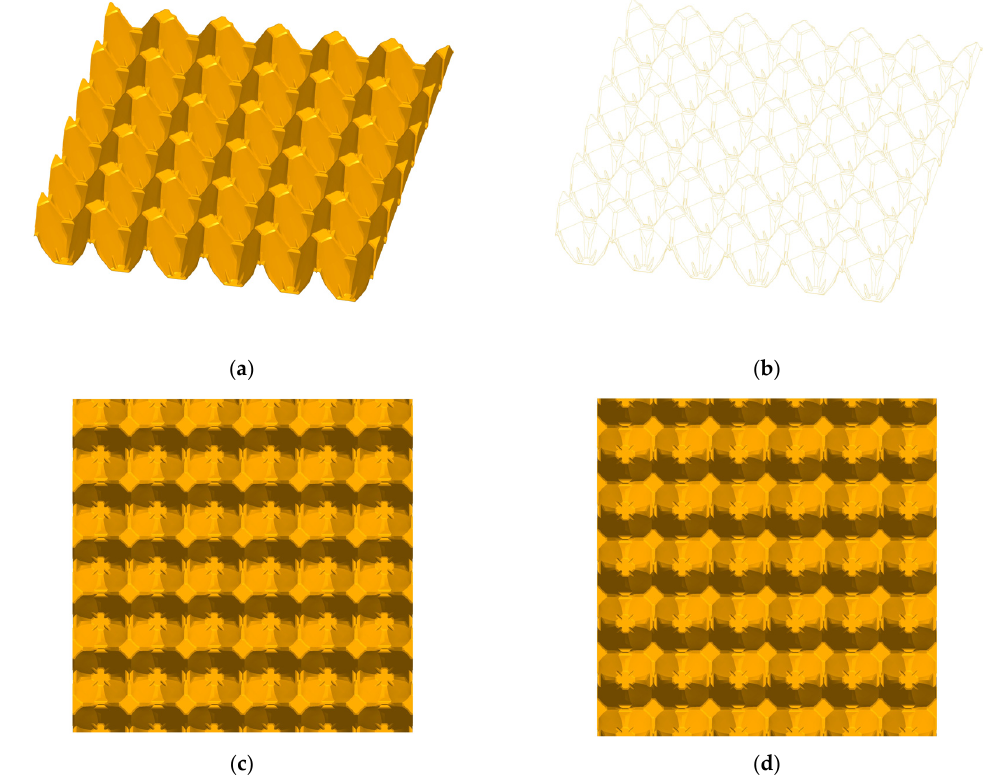
Figure 2. A 3-dimensional model of modified tray ( a – b ), view from the top ( c ), and view from the bottom ( d ).